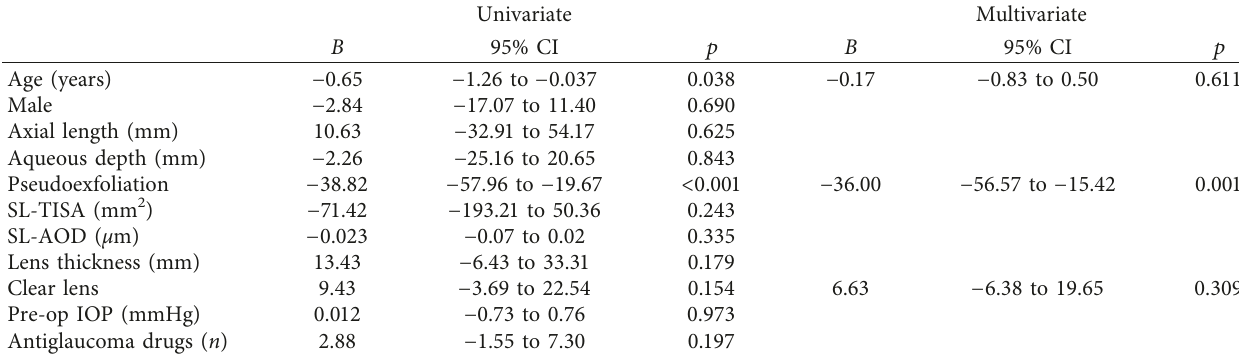
Table 3: Analysis of the association between demographic and anatomical parameters and endothelial cell density percentage change.